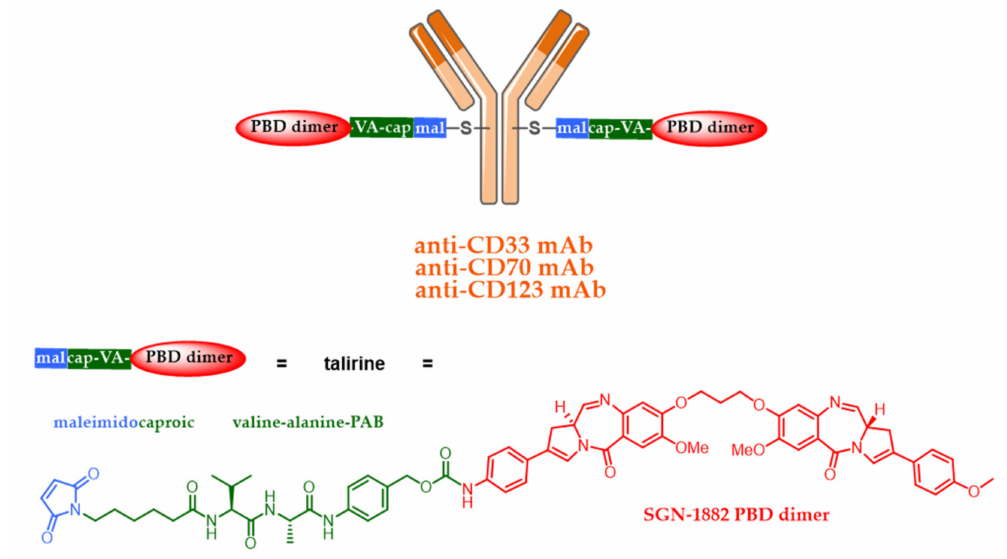
Figure 8. Homogeneous ADC with a DAR 2 carrying talirine including a dimeric derivative of pyrrolobenzodiazepine (PBD; SGN-1882).